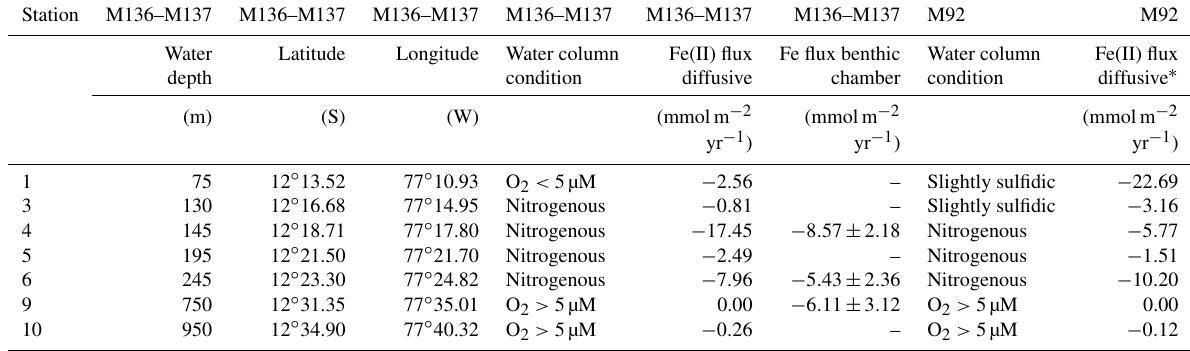
Table 2. Comparison of benthic diffusive Fe(II) fluxes out of the sediment and geochemical bottom water conditions between M136–M137 and M92 on the Peruvian shelf. Fluxes during M92 correspond to similar depth (see Fig. 9). Station